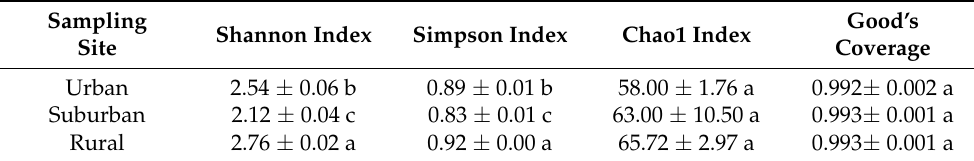
Table 2. Community diversity indices of ECM fungi in Quercus acutissima forest soil along the urban–rural